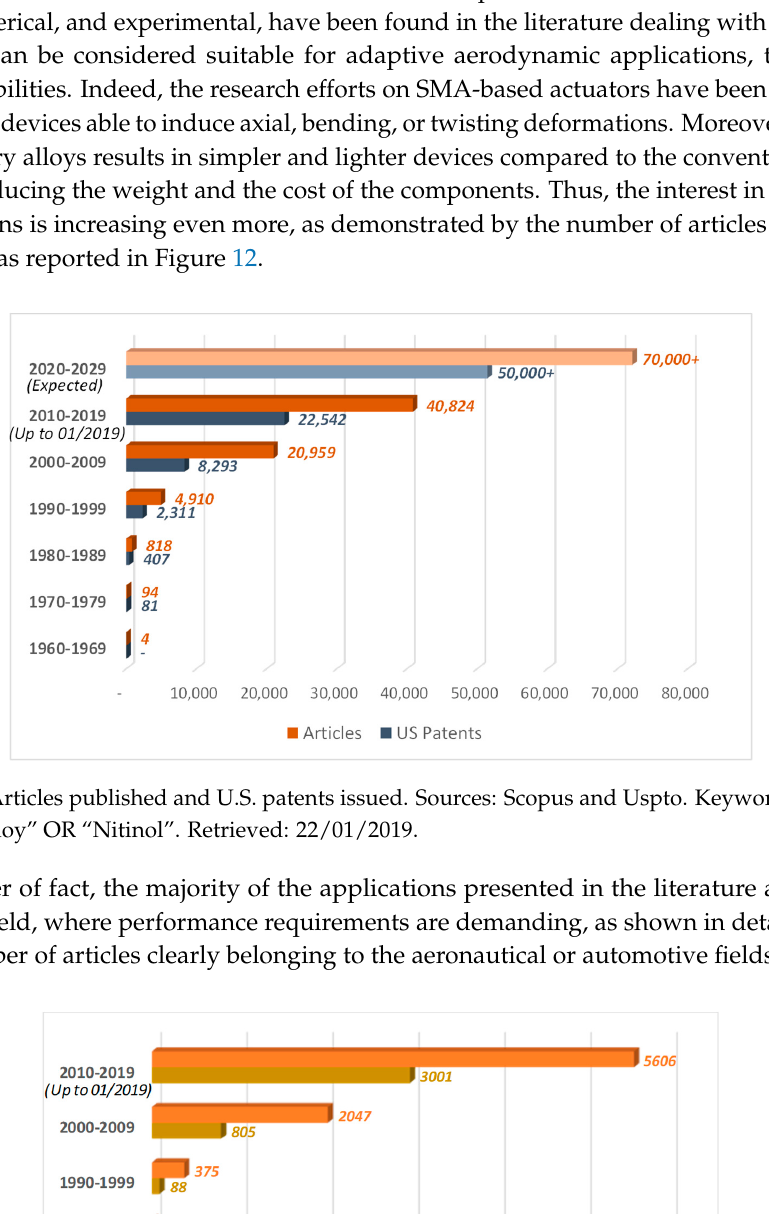
Figure 11. Case study #2: actuated structure. (unit: mm).